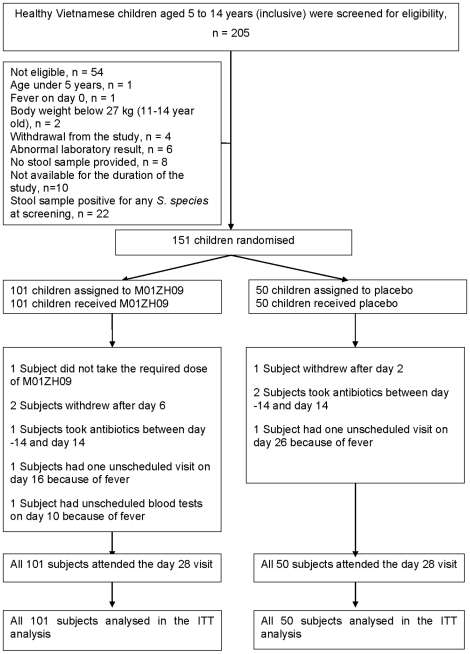
Flow of subjects.